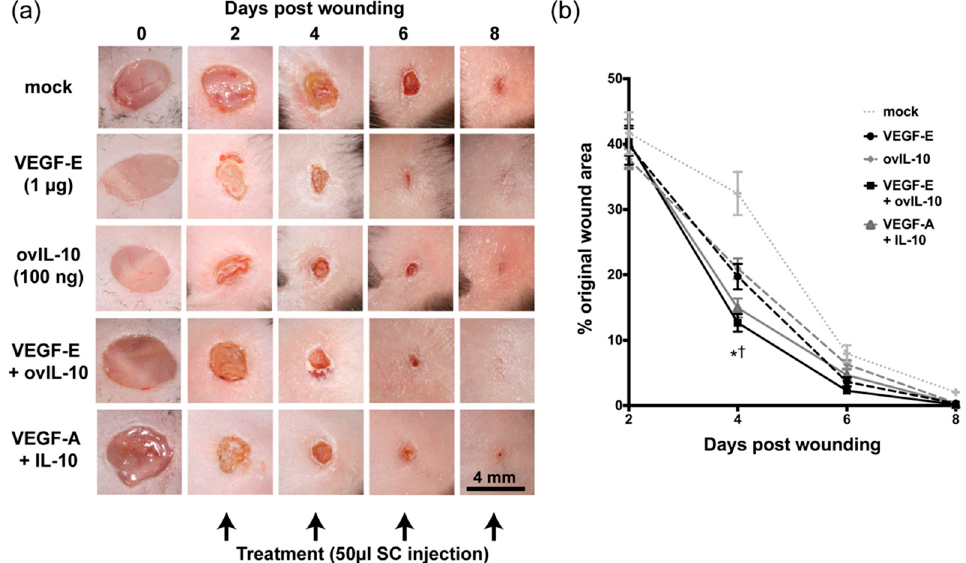
Figure 1. VEGF-E and ovIL-10 synergistically enhance wound closure. ( a ) Representative photographs of the healing process of 4 mm cutaneous full-thickness punch wounds following treatment with saline (mock), VEGF-E, ovIL-10, VEGF-E and ovIL-10, or VEGF-A and IL-10. Timing of treatments is indicated below, with dosages listed below the treatments. Scale bar = 4 mm. ( b ) Kinetics of wound closure in groups of mice following SC injection of the indicated treatment. Data are presented as the mean ± SEM; n = 8 wounds, and p values ≤ 0.05 are indicated when significant differences between mock-treated wounds and all other wound groups (*) or VEGF-E and ovIL-10 combination-treated and VEGF-E and IL-10 individually treated wounds (†) were identi fi ed.